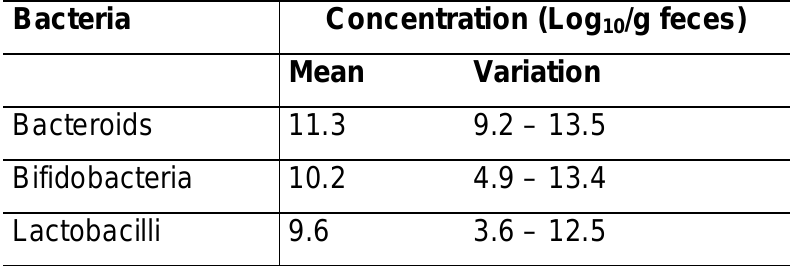
Table 1: Concentration of bacteria in the human large